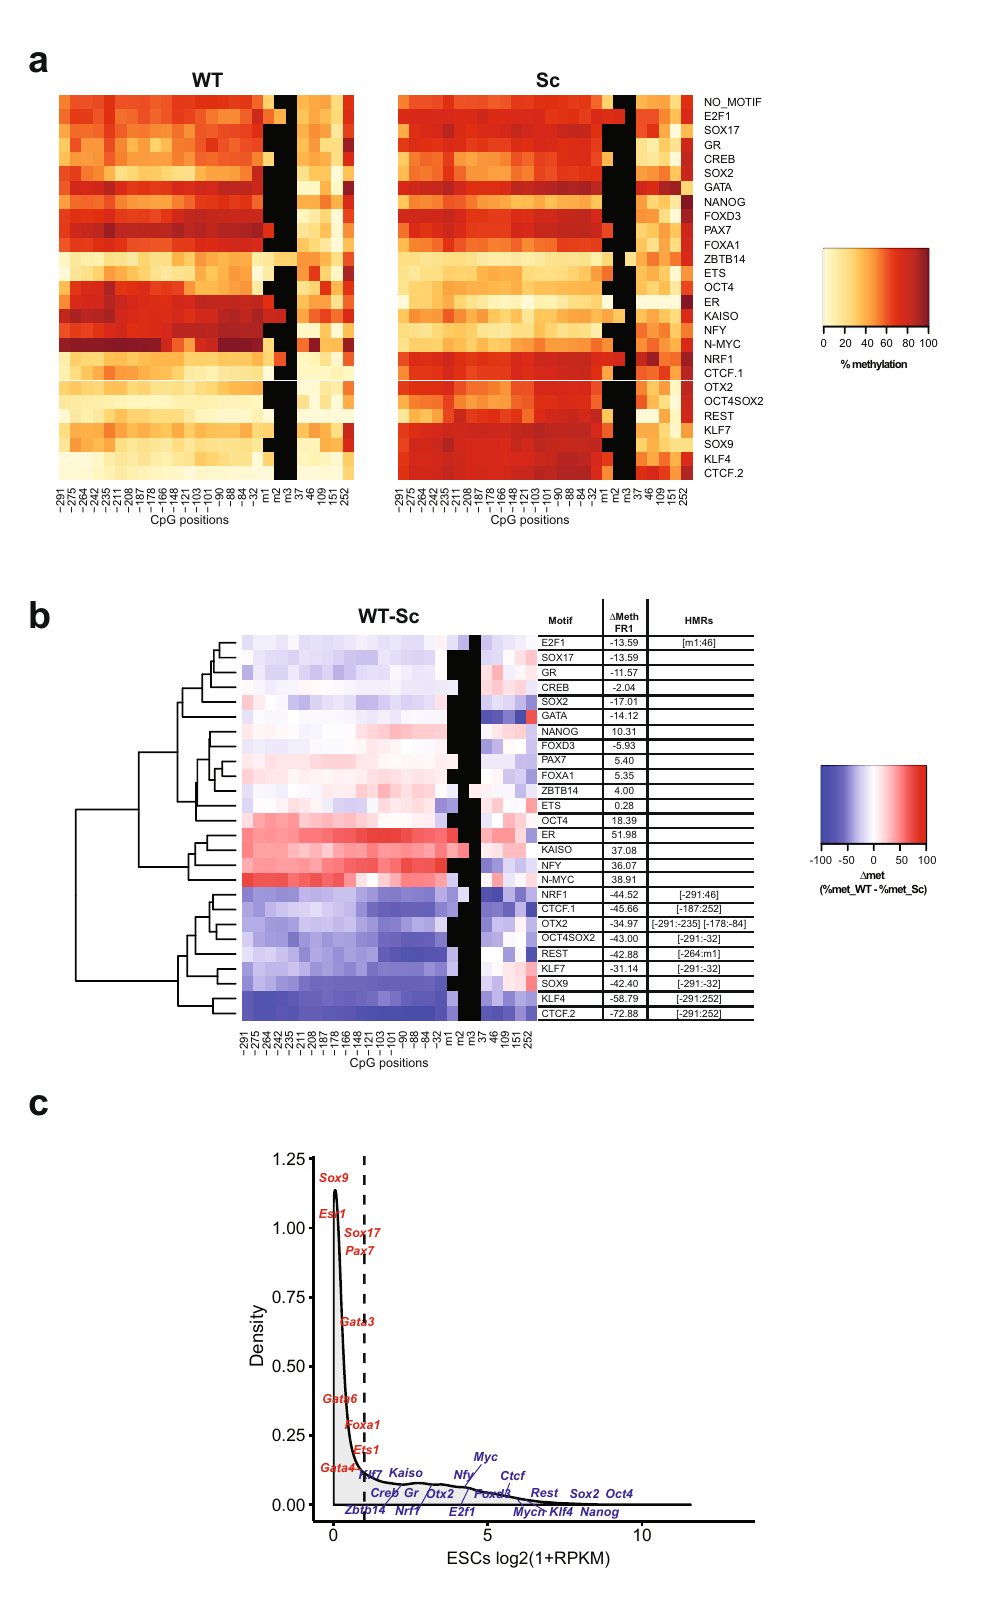
(Supplementary Figs. 5a and 7a) and 85.9% around Sc motifs in the + SssI condition (Supplementary Figs. 5a and 7b). In the − SssI condition, statistical analysis identi fi ed HMRs around CTCF.1, CTCF. 2, REST, KLF4, OCT4SOX2, SOX9 and N-MYC binding sites (Fig. 4e and Supplementary Table 3). On the other hand, FR1/ + SssI data analysis identi fi ed CTCF, REST,